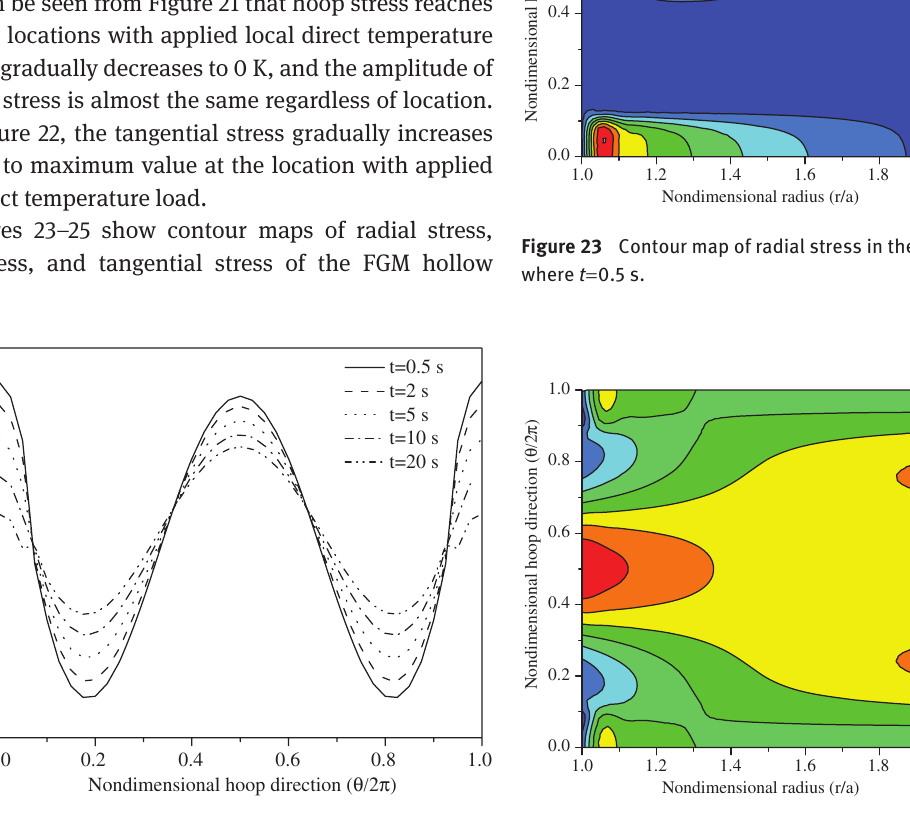
Figure 21 Distributions of hoop stress along the hoop direction of the FGM hollow cylinder at different times.